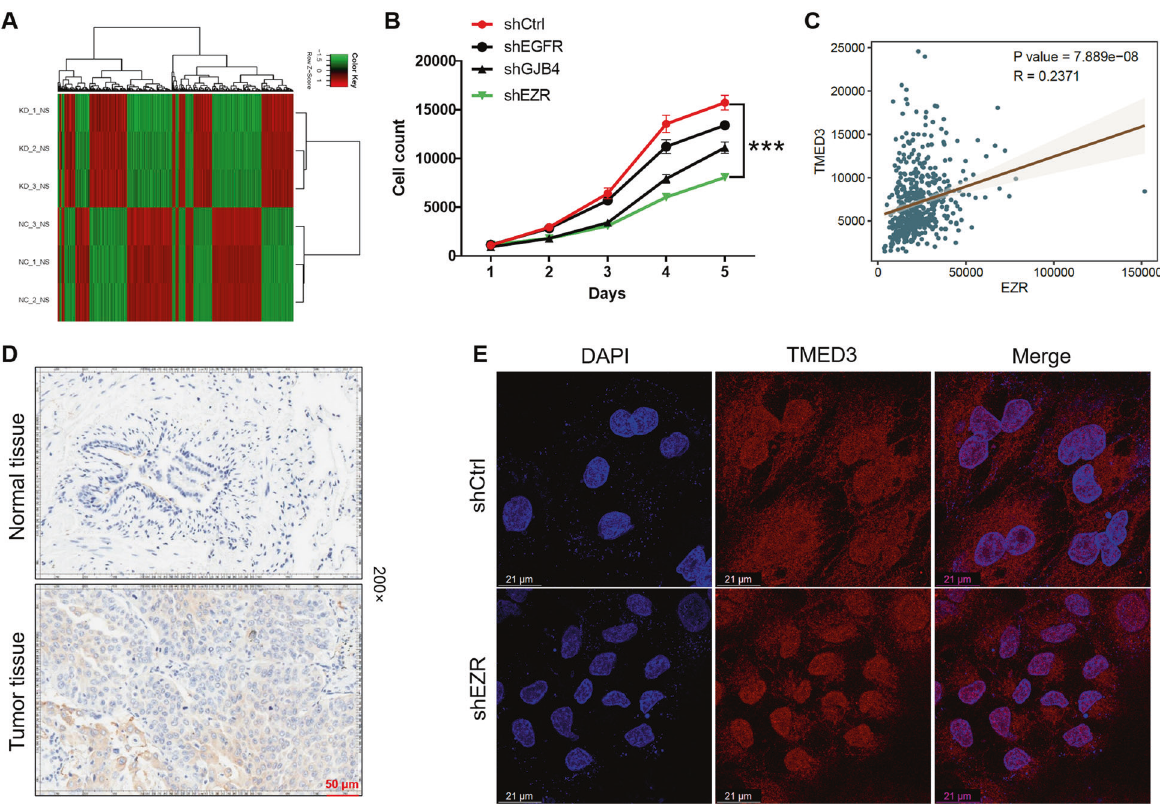
Fig. 4 Exploration of underlying mechanism of TMED3 in LUSC. A NCI-H520 cells transfected with lentivirus shCtrl ( n = 3) or shTMED3 ( n = 3) were RNA sequenced to determine DEGs. B MTT assay was used to evaluate the effect of EGFR, EZR, and GJB4 knockdown on proliferation of NCI-H520 cells. C Pearson correlation analysis were performed to examine the relationship between TMED3 and EZR. D The expression of EZR in normal and tumor tissues was detected by IHC analysis (200× magni fi cation: scale bar = 50 μ m). E Co-localization was observed by immuno fl uorescence. Scale bar = 21 μ